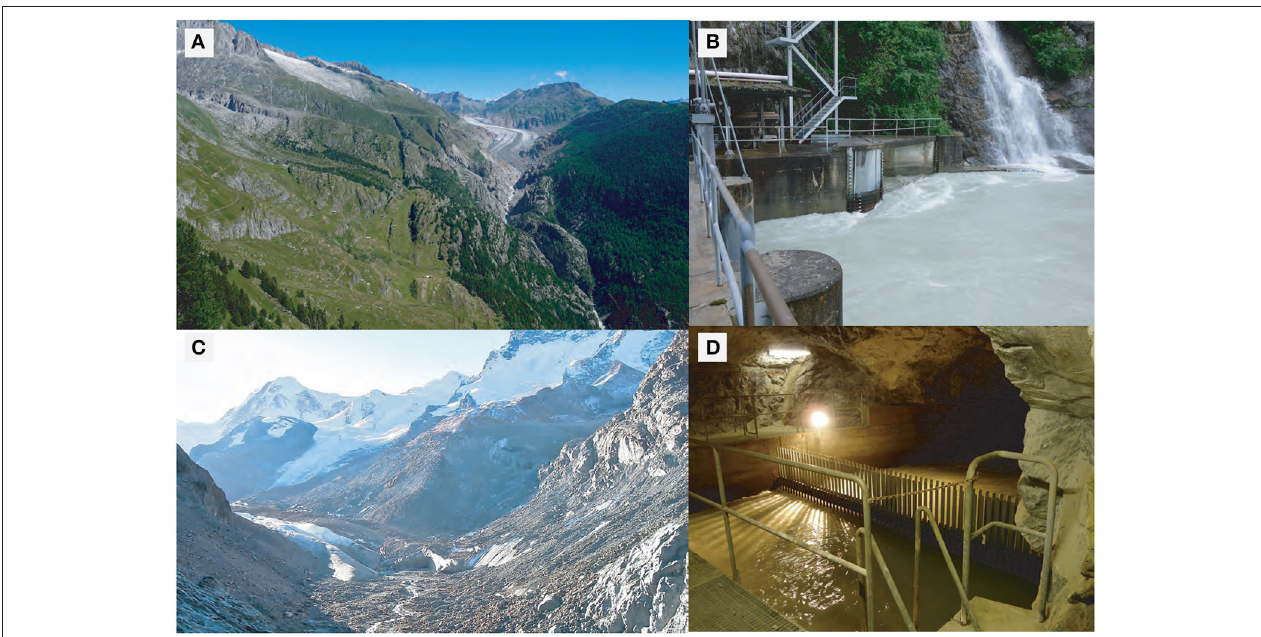
FIGURE 2 | The glacier termini of Aletschgletscher in 2016 (A) and Gornergletscher in 2017 (Archives VAW/ETH Zürich; St. Walter) (C) , as well as the water intake for the Aletschgletscher catchment (B) and sediment trap below the Gornergletscher catchment (D) . Note that both glaciers terminate near bedrock gorges. Approximate locations of photographs (A,C) are given in Figure 1